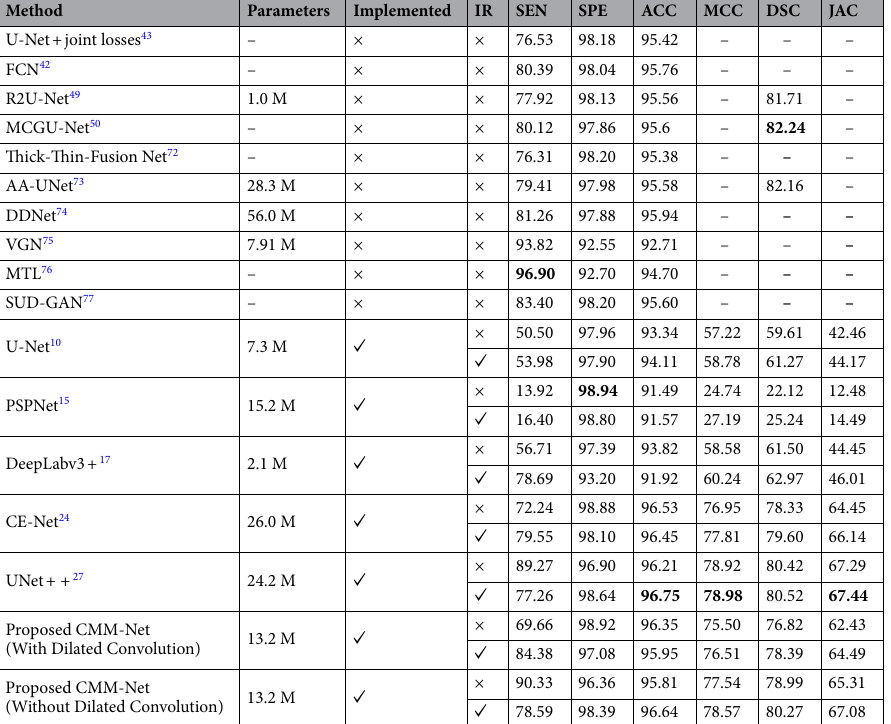
Table 4. Retinal blood vessels segmentation performances (%) via the proposed CMM-Net compared to the recent deep learning approaches. R2U-Net: Recurrent Residual CNN based U-Net; MCGU-Net: Multi-level Context Gating; AA-UNet: Attention guided U-Net with Atrous convolution; DDNet: Dense Dilated Network; VGN: Vessel Graph Network; MTL: Multi-Task Learning; and SUD-GAN + : Short connection with Dense